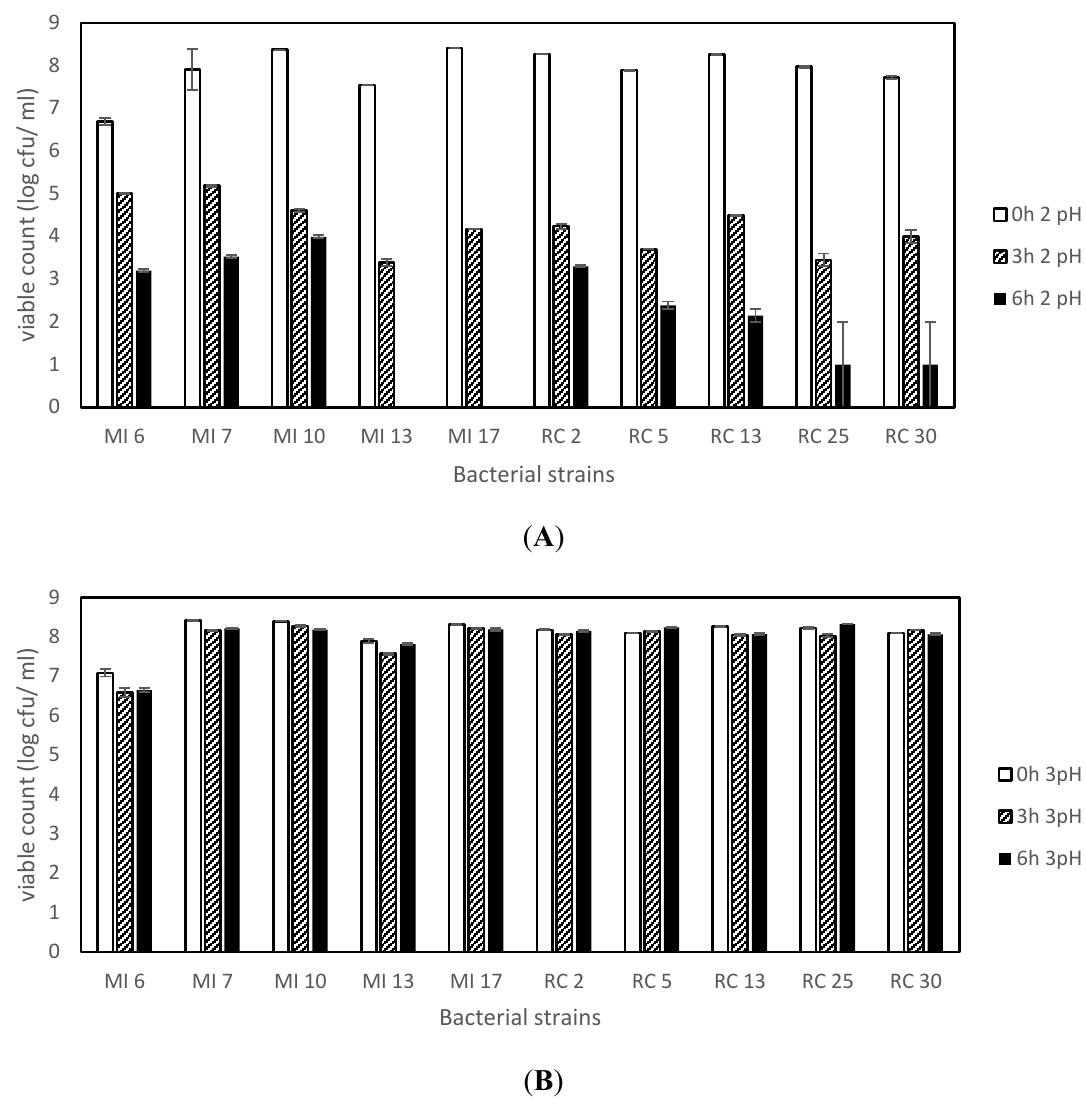
Figure 1. Viability of the strains expressed as log cfu/mL after 0, 3 and 6 h incubation at pH 2 ( A ) and pH 3 ( B